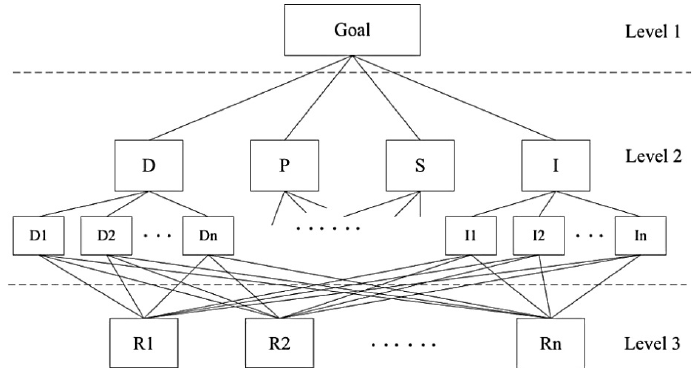
Fig. 1: The analytical hierarchical structure of